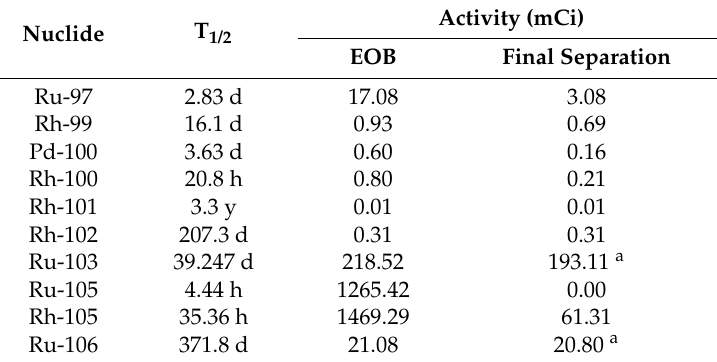
Table 4. Radioactive quantities of ruthenium, rhodium, and palladium isotopes produced in a proton